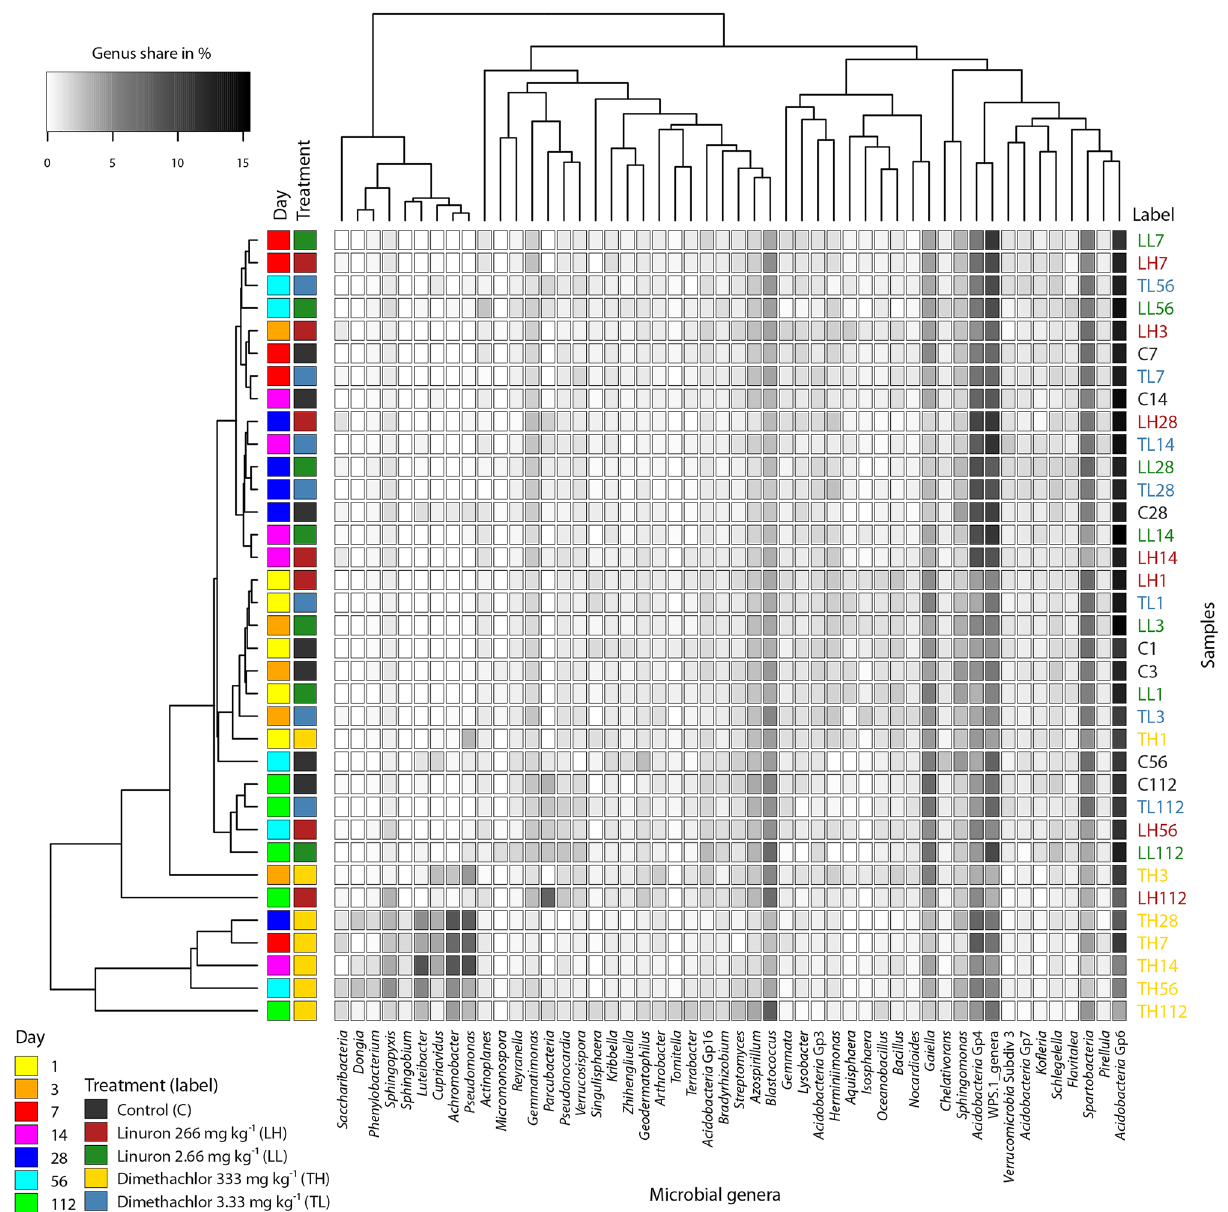
Figure 5. Heatmap of most common bacterial genera in soil samples treated by herbicides linuron and